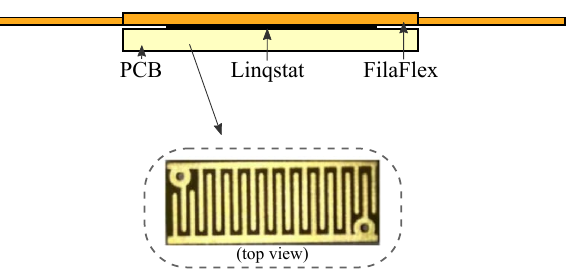
Figure 3. Custom FSR layer structure. Detail of the PCB with the comb electrodes.